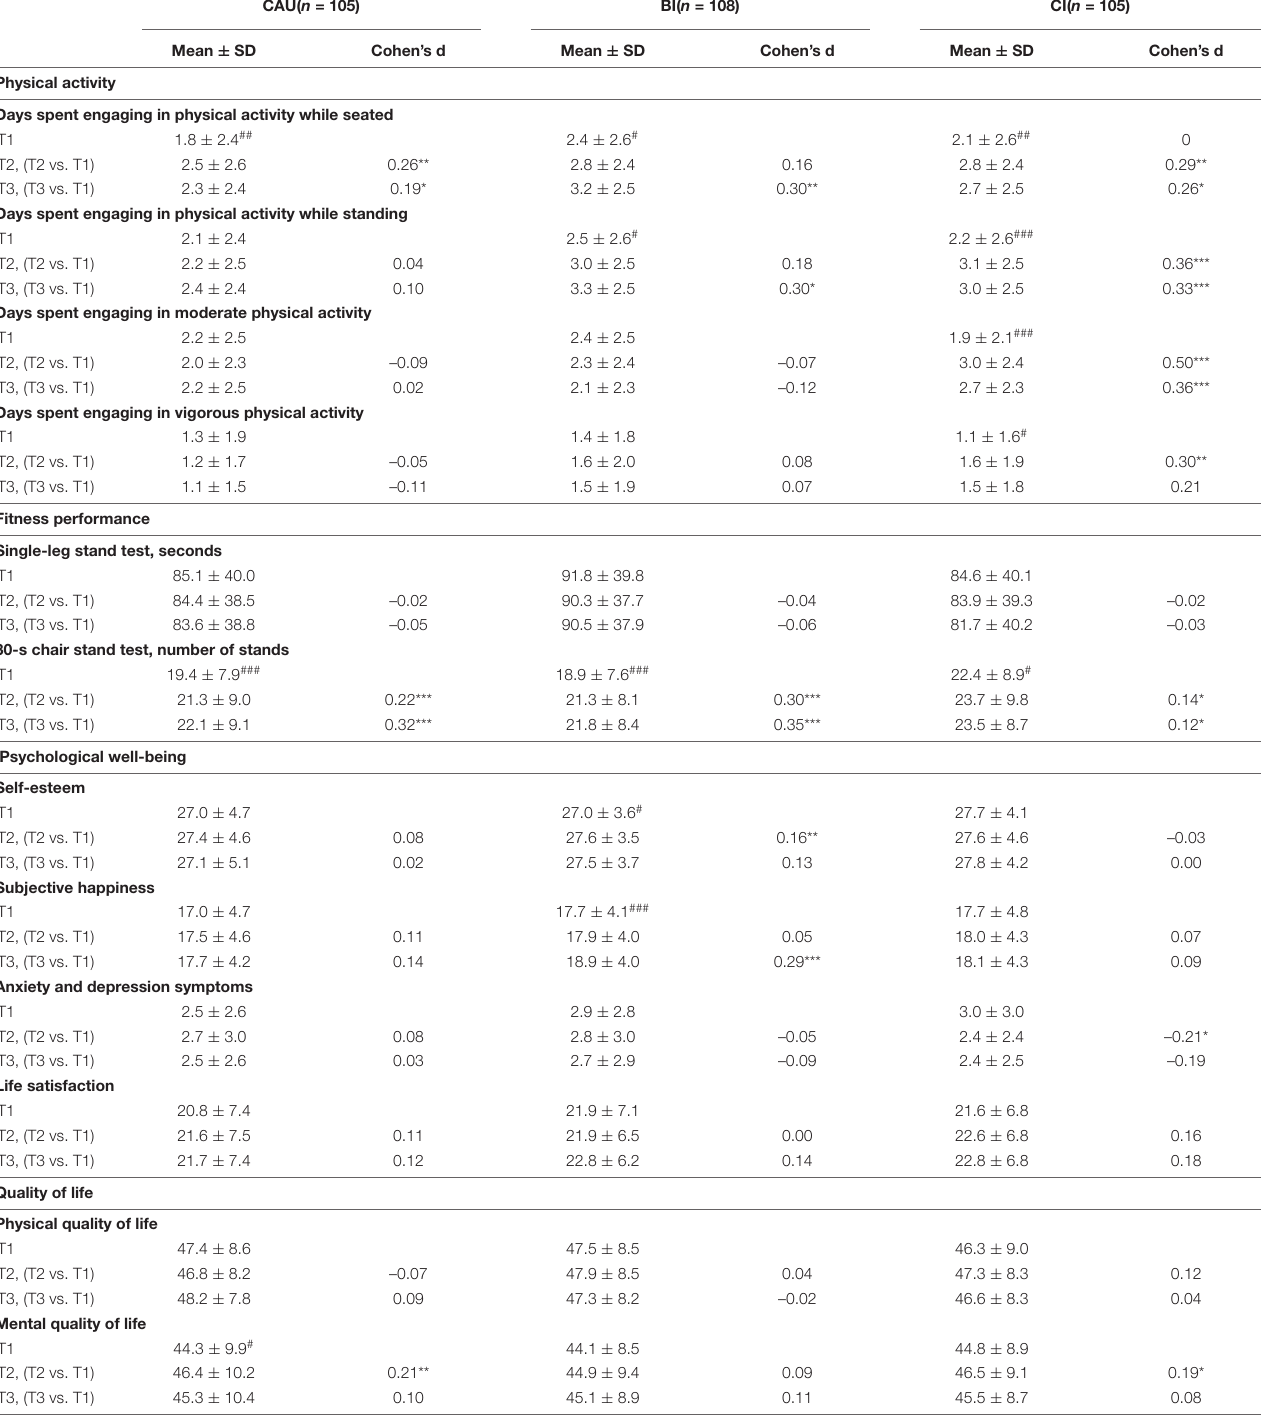
TABLE 3 | The within-group difference in physical activity, fitness performances, psychological well-being, and quality of life at 1- and 3-month follow-up in three groups: Intention-to-treat analysis. CAU( n = 105) BI( n = 108) CI( n = 105) Mean ± SD Cohen’s d Mean ± SD Cohen’s d Mean ± SD Cohen’s